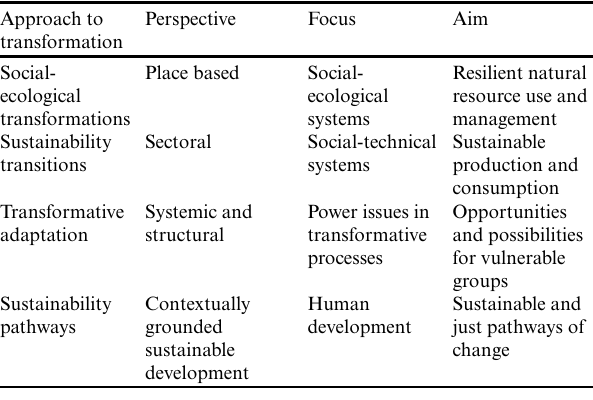
Table 1 . Overview of four prominent conceptual approaches to transformation based on Patterson et al. (2017). These conceptual approaches to transformation have different perspectives, foci, and aims, which show the plurality of how sustainability transformations are understood within